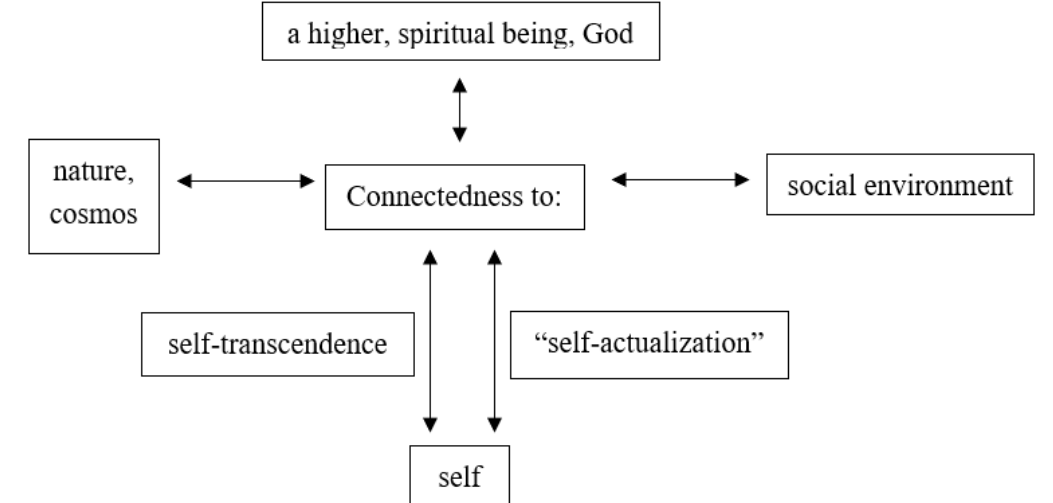
Figure 2. The model of spirituality as connectedness by Bucher. Based on Spiritualität (p. 40) by A. A. Bucher, 2014, Weinheim: Beltz. © by Beltz.